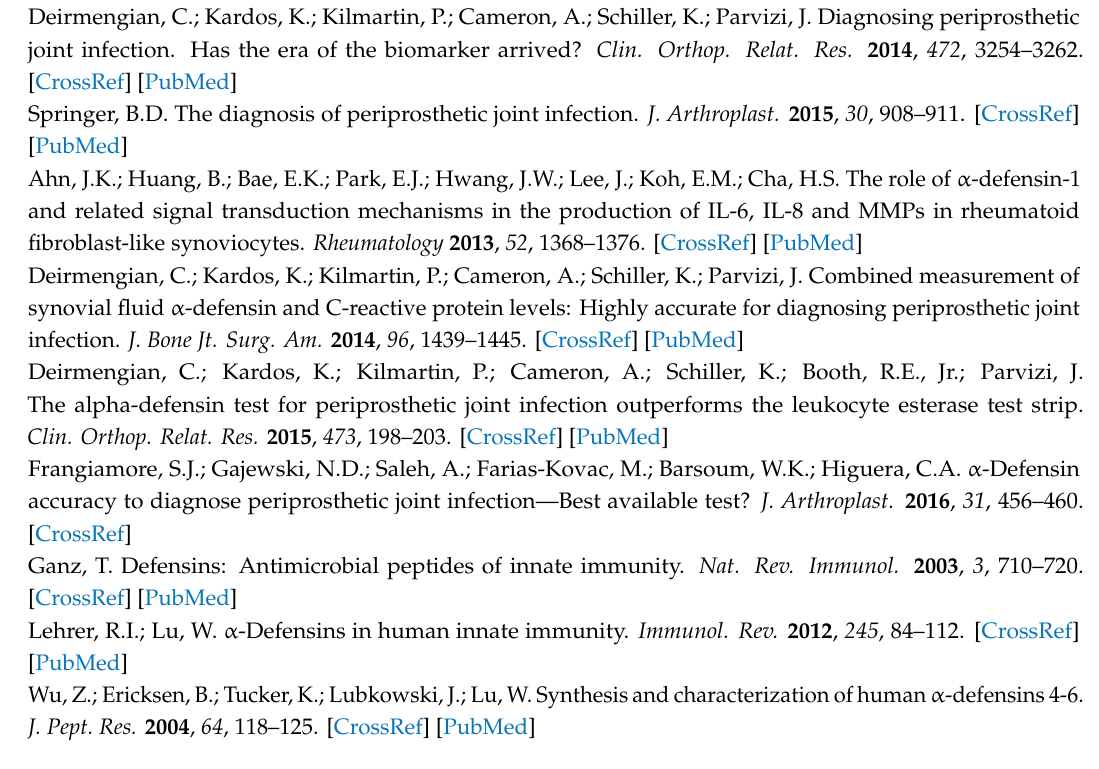
Figure S1: Electrospray ionization mass spectrometry (ESI-MS) spectra of the human α -defensins, HNP1, HNP2, and HNP3. Table S1: α -Defensins (HNP1–3) concentrations obtained by HPLC measurements in patients with various